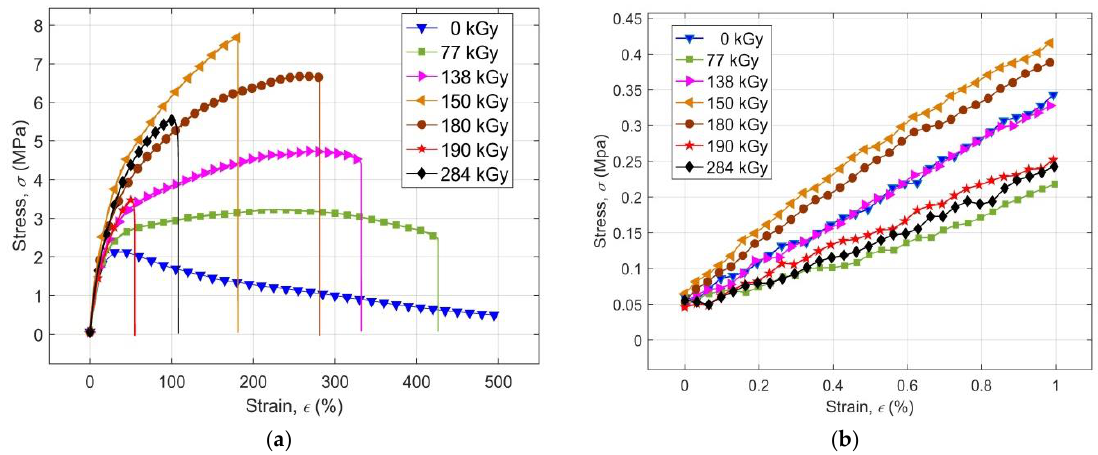
Figure 1. ( a ) Experimental average engineering stress-strain curves of non-irradiated polymeric system PMX3 and of polymeric system PMX3 modified by various radiation doses of ionizing EB radiation; ( b ) Detailed representation of the linear region of the stress-strain curves.